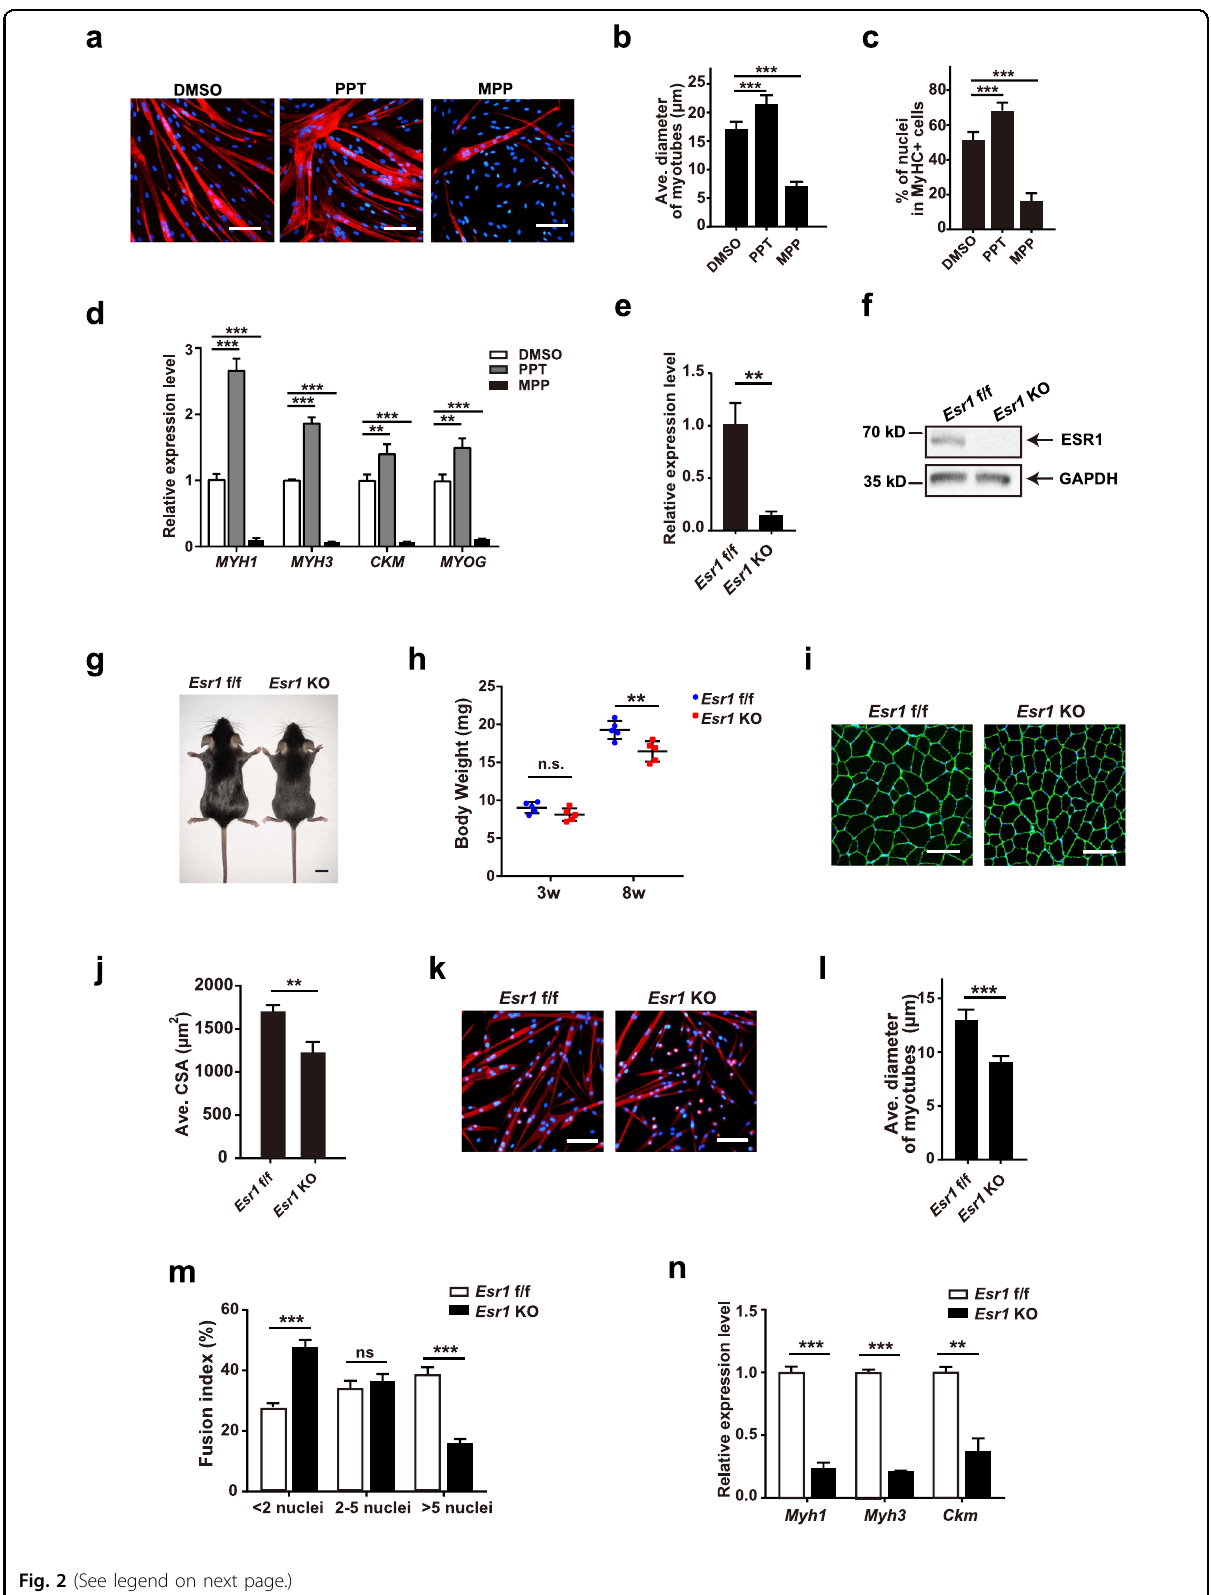
Fig. 2 (See legend on next